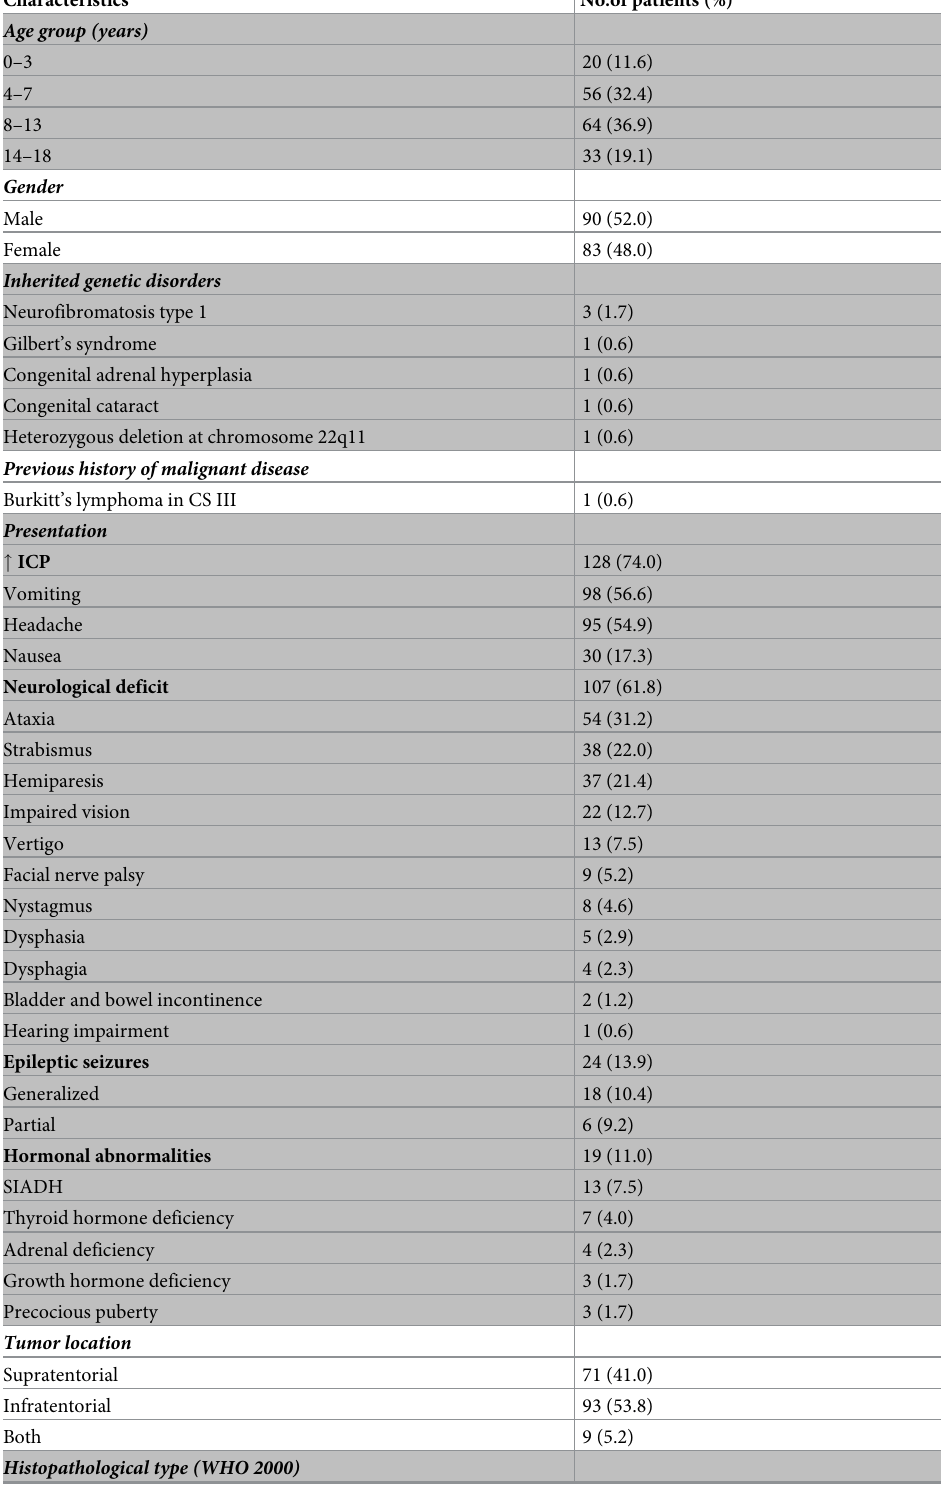
Table 1. Patients’ clinical characteristics and treatment